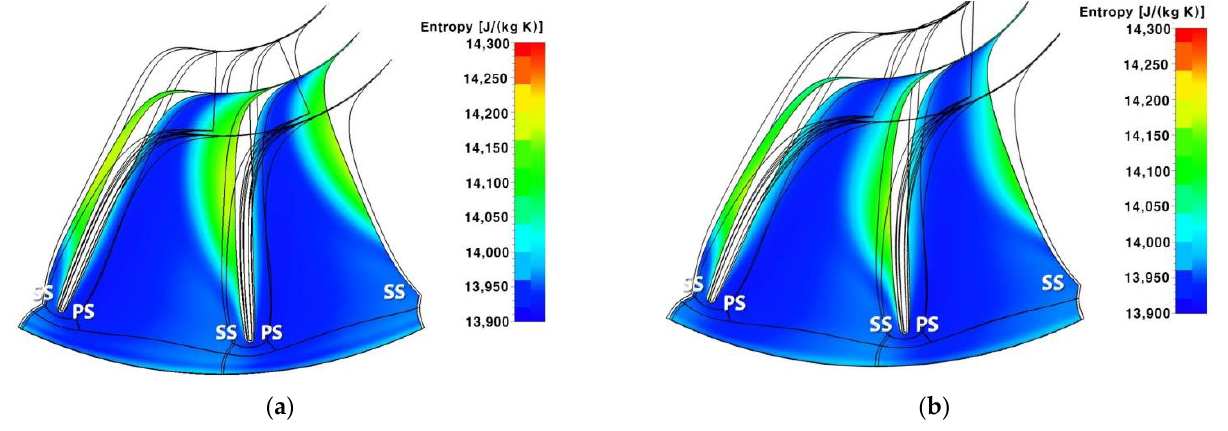
Figure 15. Comparison of entropy distribution at mid-span of the rotor (Plane 1): ( a ) original model and ( b ) optimized model.